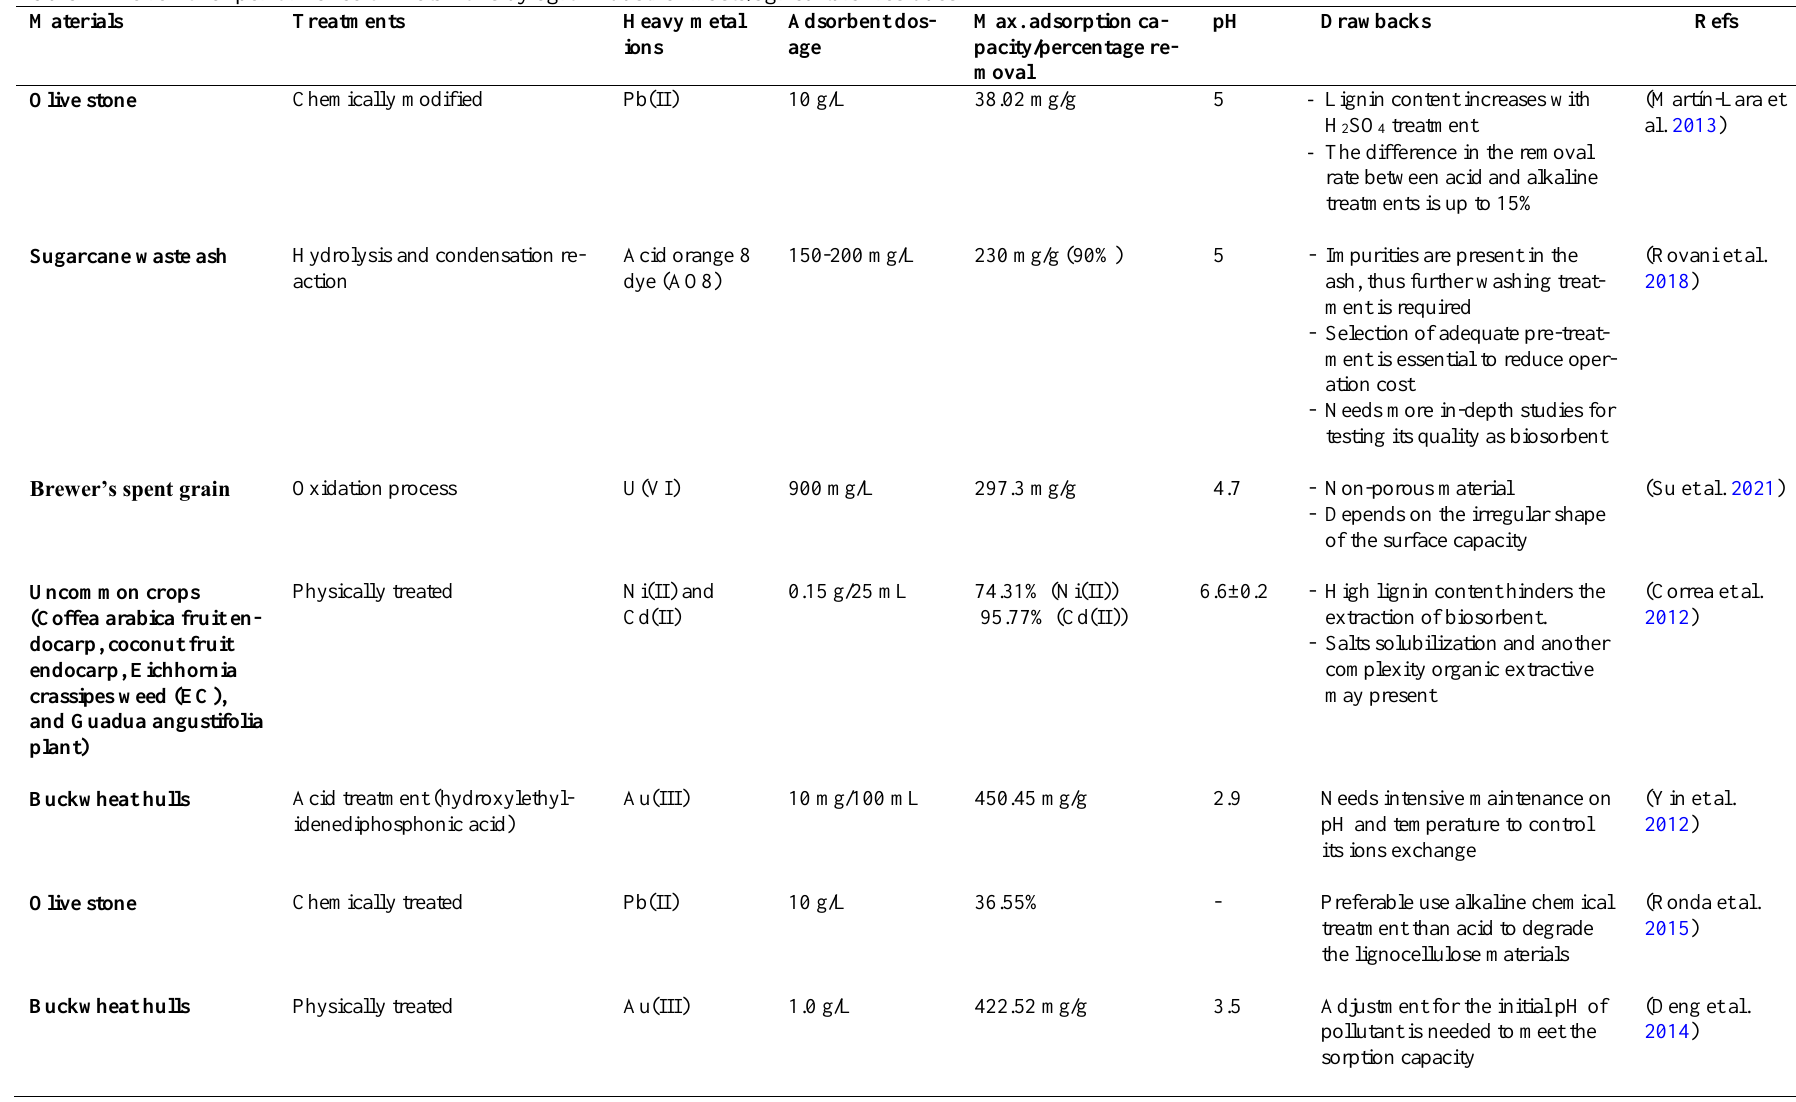
Table 4 The removal performance of metal ions by agro-industrial waste/agricultural residues